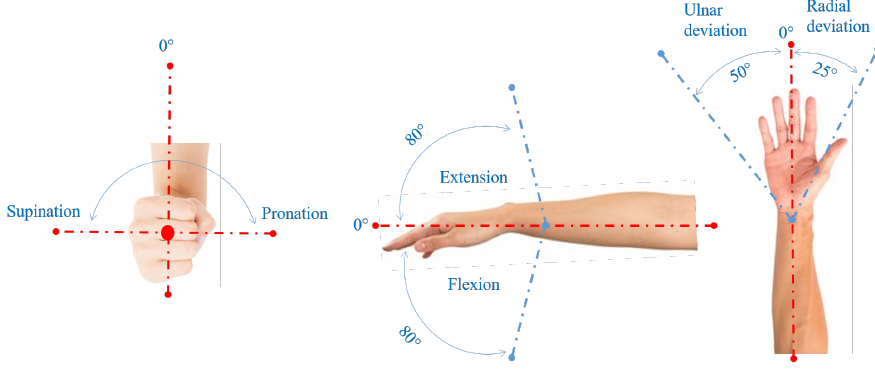
Figure 4. Healthy wrist range of